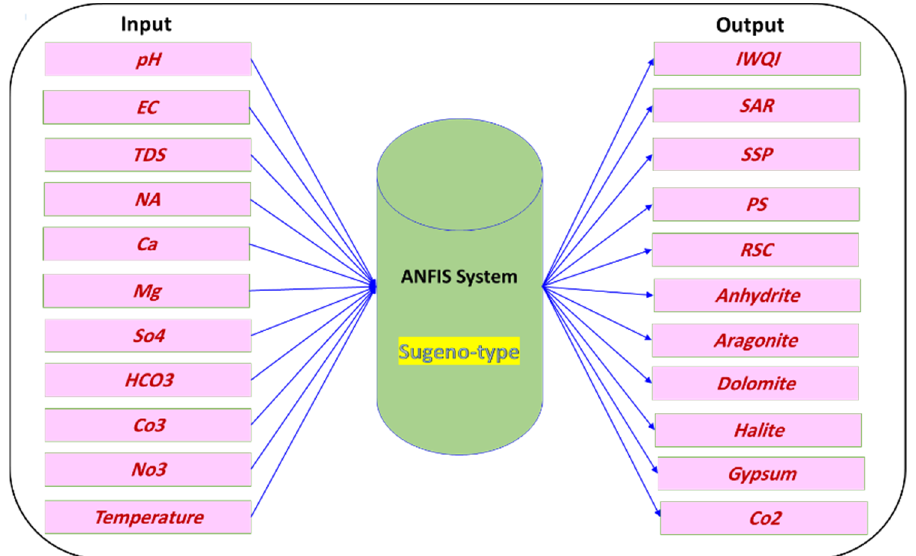
Figure 4. ANFIS system with a two-rule Sugeno system.